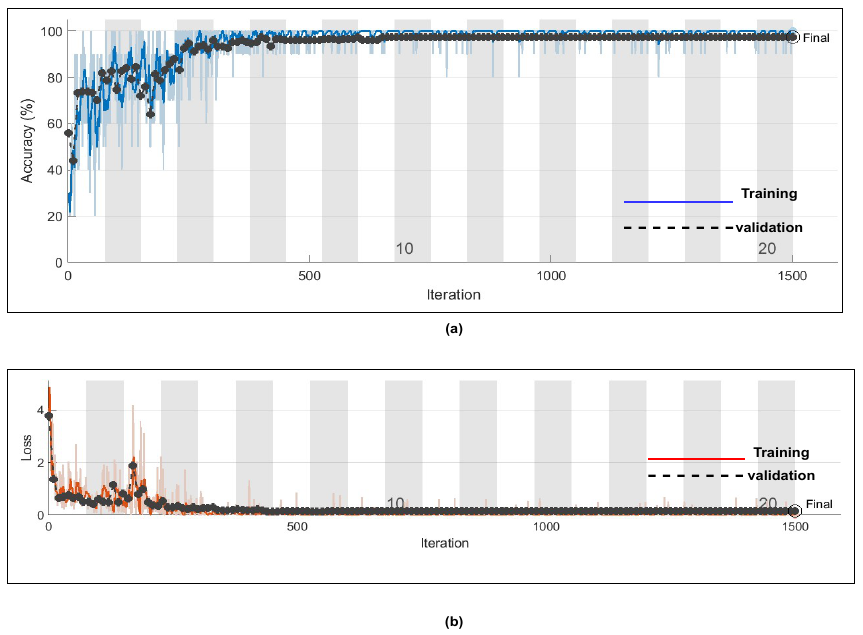
Figure 10. Confusion Matrix represents accuracy of the proposed model without k-fold cross valida- tion 2D-CNN-LSTM .